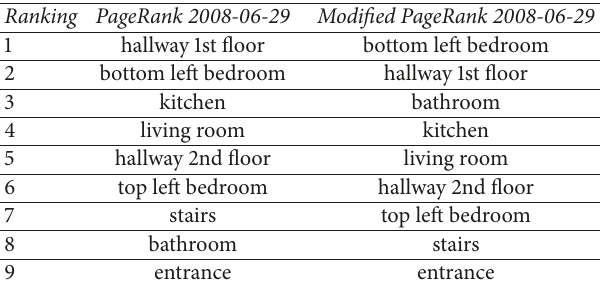
Table 5: Results of the second